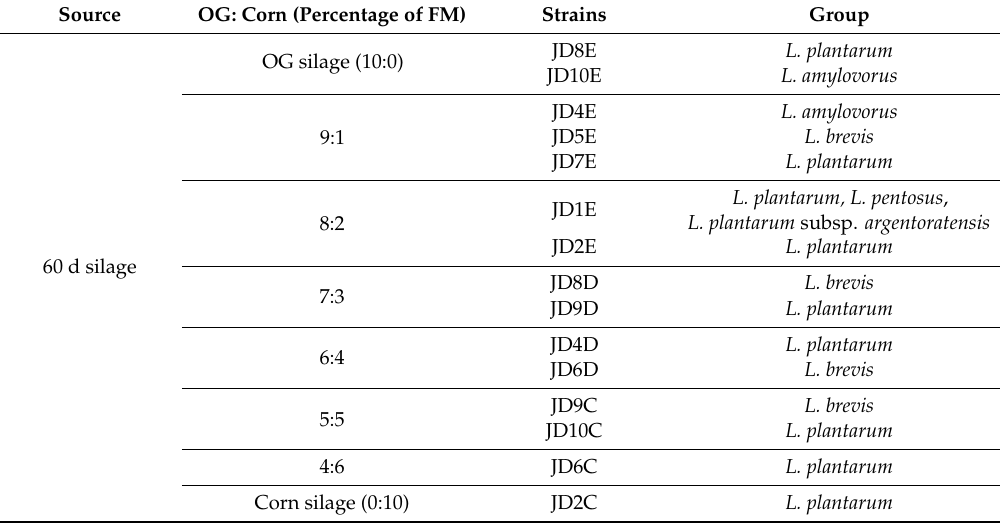
Table 5. Swainsonine (SW) removal rate (%) in Oxytropis glabra (OG) broth by representative LAB strains of different species.